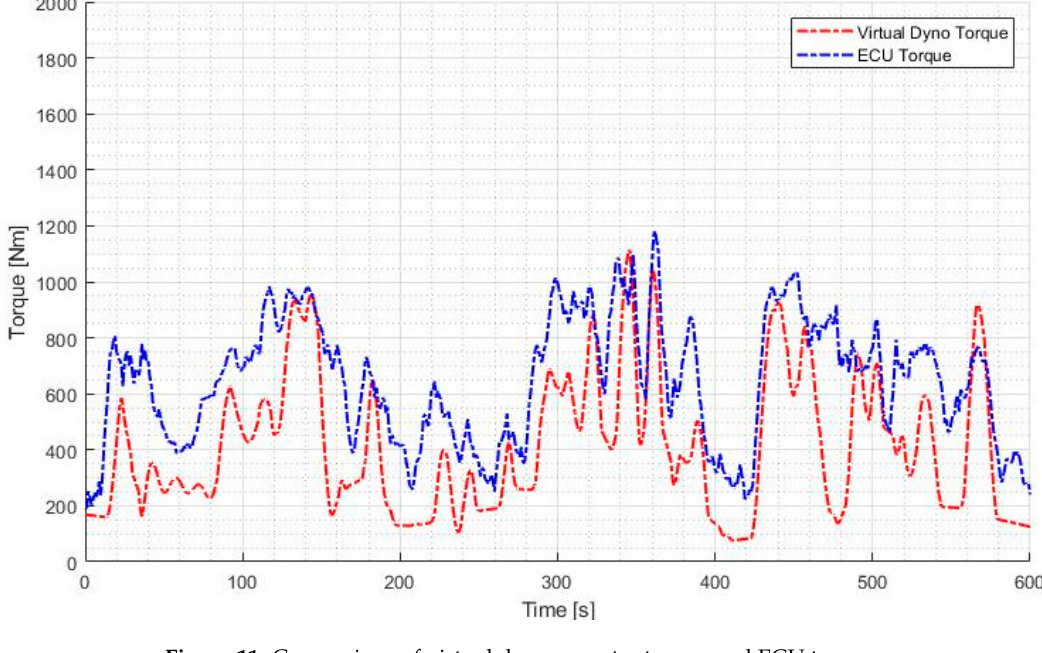
Figure 11. Comparison of virtual dynamometer torque and ECU torque. Sensors 2020 , 20 , x FOR PEER REVIEW